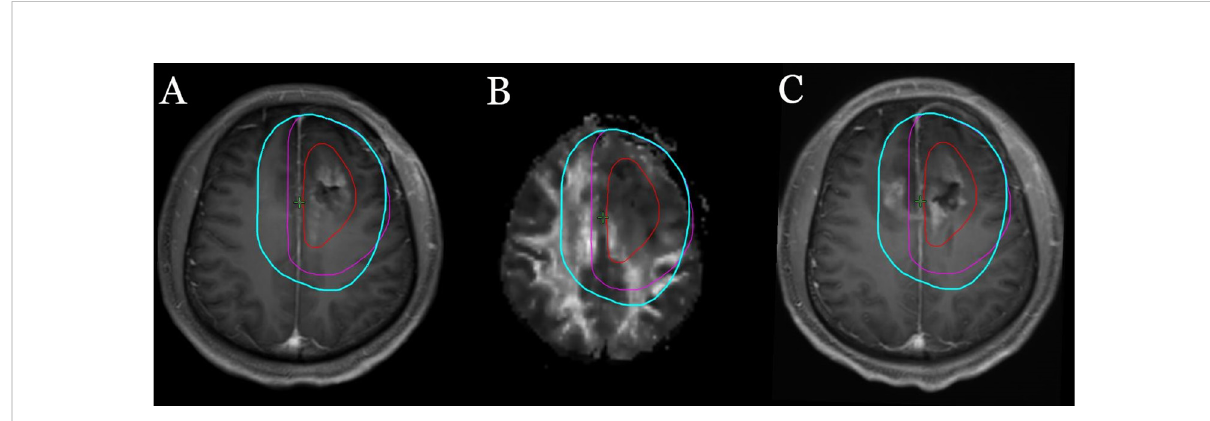
FIGURE 6 A patient with left frontal glioblastoma, the ipsilateral body of the corpus callosum was involved by tumor before surgery. The red line represents GTV, the purple lines represent CTV outlined according to the EORTC guidelines, and the light blue lines represent CTV outlined according to our methods. (A) Target area is shown in the postoperative T1 enhancement sequence. (B) Target area is shown in DTI Fa sequence. (C) The relationship between tumor recurrence and different target